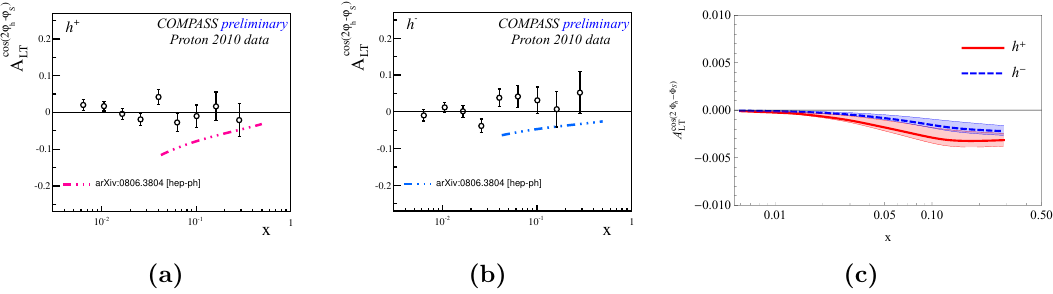
Figure 15. A cos(2 (cid:30) h (cid:0) (cid:30) S ) as a function of x from a proton target: preliminary COMPASS data [167] LT (a,b), and our calculation for COMPASS kinematics (c) shown separately for reasons explained in the caption of (cid:12)gure